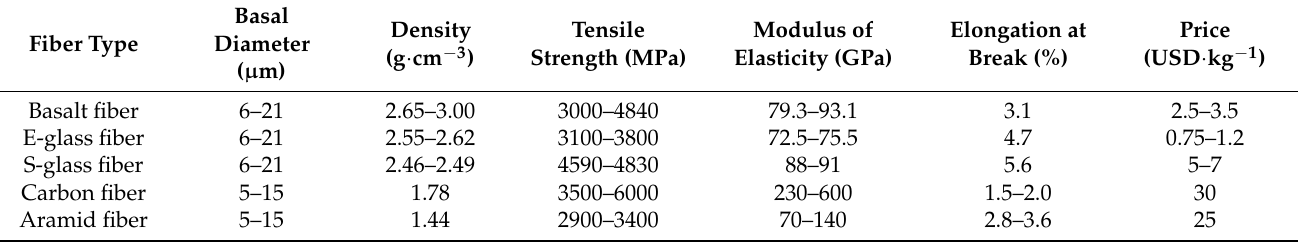
Figure 4. Schematic diagram of bare BF electric double layer [29]. Table 1. Comparison of mechanical properties between BF and other fibers [26,32].